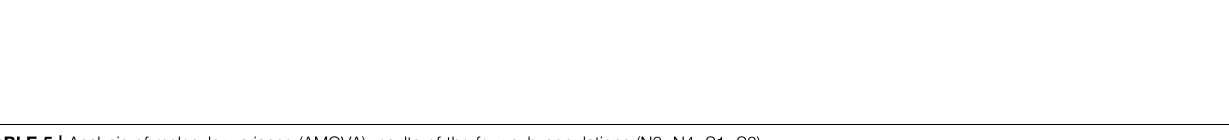
TABLE 5 | Analysis of molecular variance (AMOVA) results of the four sub-populations (N3, N4, S1, S2). df Est. Var Source of variation Among groups